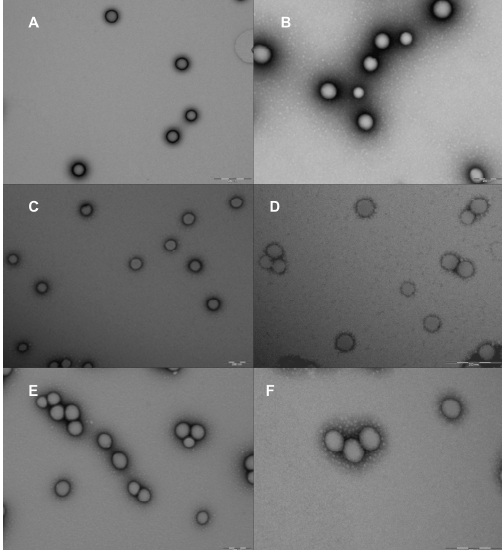
Figure 3. Transmission electron microscopy (TEM) images of blank NPs ( A ); and drug loaded NPs: NPs 1 ( B ); NPs 1a ( C ); NPs 1b ( D ); NPs 1c ( E ) NPs 1d ( F ). Bar lengths: 500 nm ( A ), 200 nm ( B – F ).